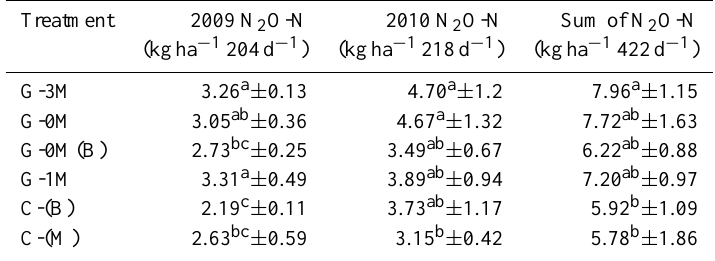
Table 3. Cumulative N 2 O losses (N 2 O-Nkgha − 1 ) over 204 and 218days in the years 2009 (GM ley) and 2010 (barley), respectively, and sum over the two measurement periods (2009+2010). Given values are means of 4 replicate microplots ± standard deviation. Treatments not sharing the same letters are significantly different from each other within each year at the 95% confidence interval.